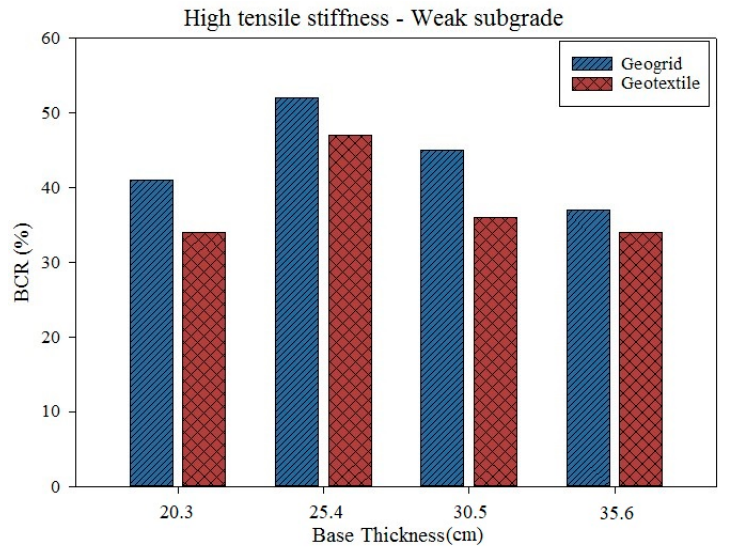
Figure 16. Changes in the BCR of the pavement reinforced with a high tensile stiffness geosynthetic on weak subgrade soil for different geosynthetic types.